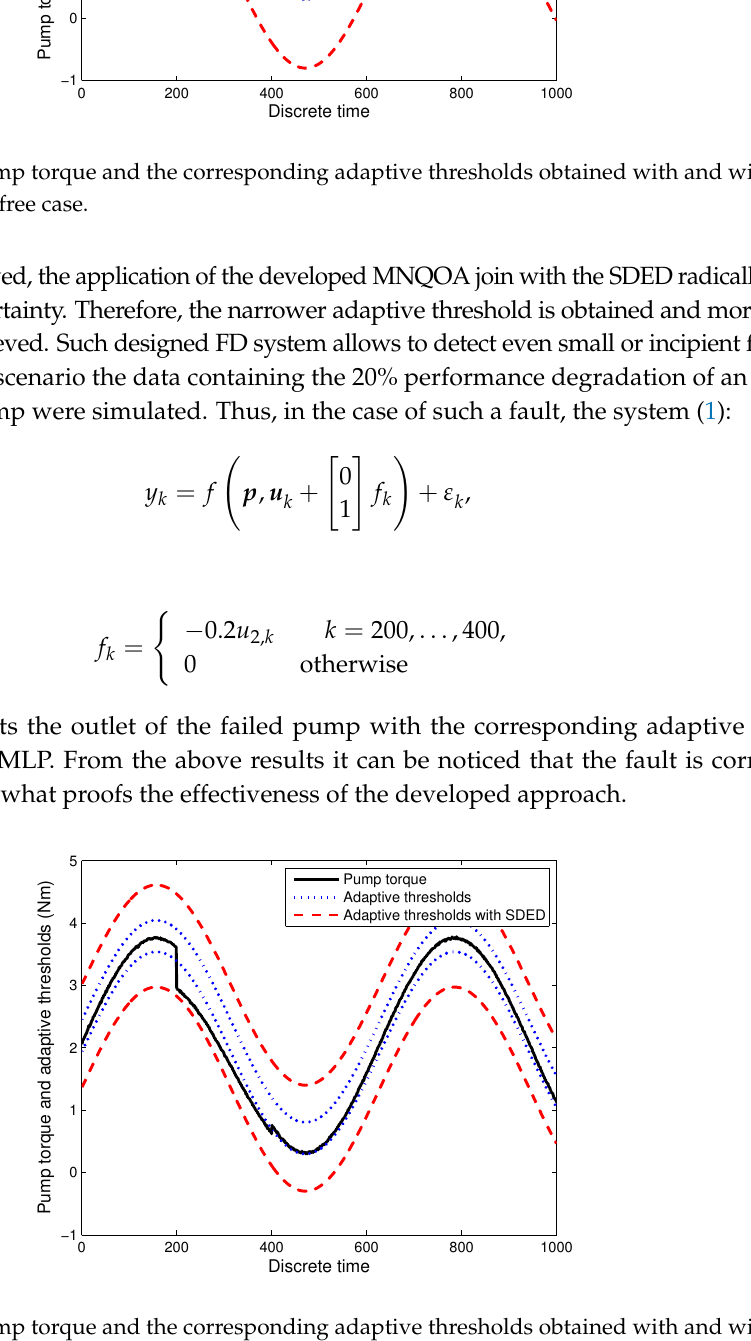
Figure 11. Real pump torque and the corresponding adaptive thresholds obtained with and without SDED for the faulty